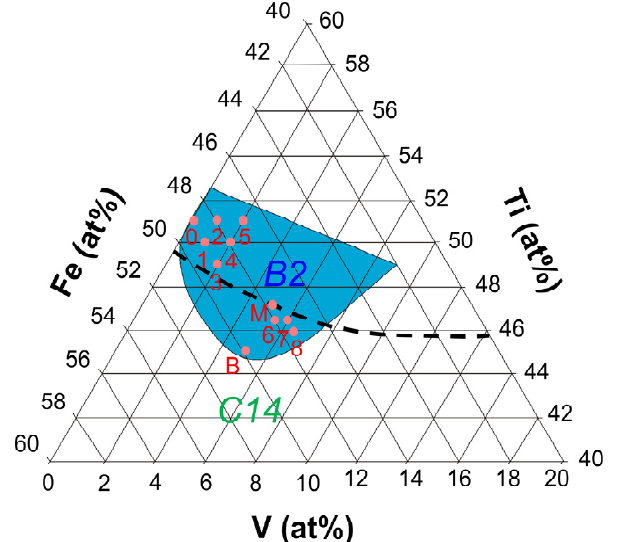
Figure 1. Horizontal section of a ternary phase diagram of Ti-Fe-V system at 1000 ◦ C [38] overlaid with designed nominal compositions of samples 0–8 and the two compositions B and M from previous studies [2,38]. The shaded region corresponds to a single phase in the B2 structure. The black dashed line is a tentative liquidus surface projection and is a border between the B2 and C14